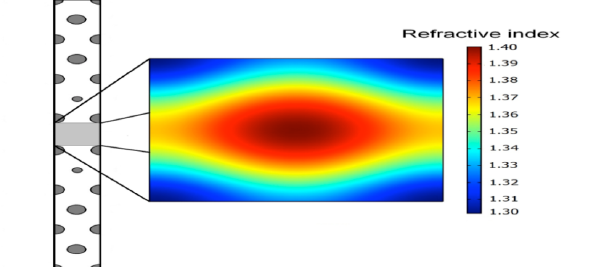
Fig. 6. As can be seen, for larger values of refractive index changes, shorter switching lengths are required.